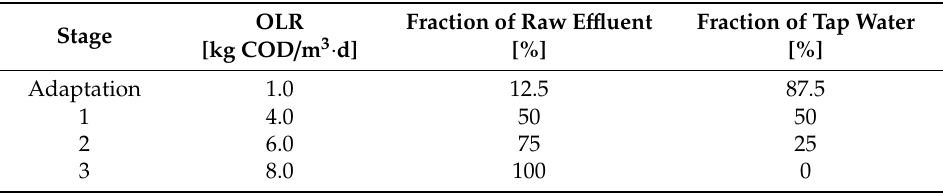
Table 2. Experimental design.